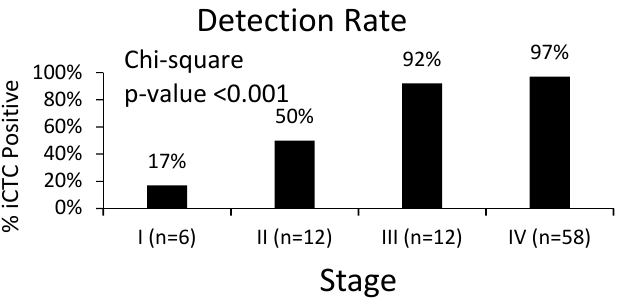
Figure 1. Flow chart representing the procedural steps of invasive circulating tumor cell (iCTC) isolation and quantification.: CAM indicates collagen-based adhesion matrix.